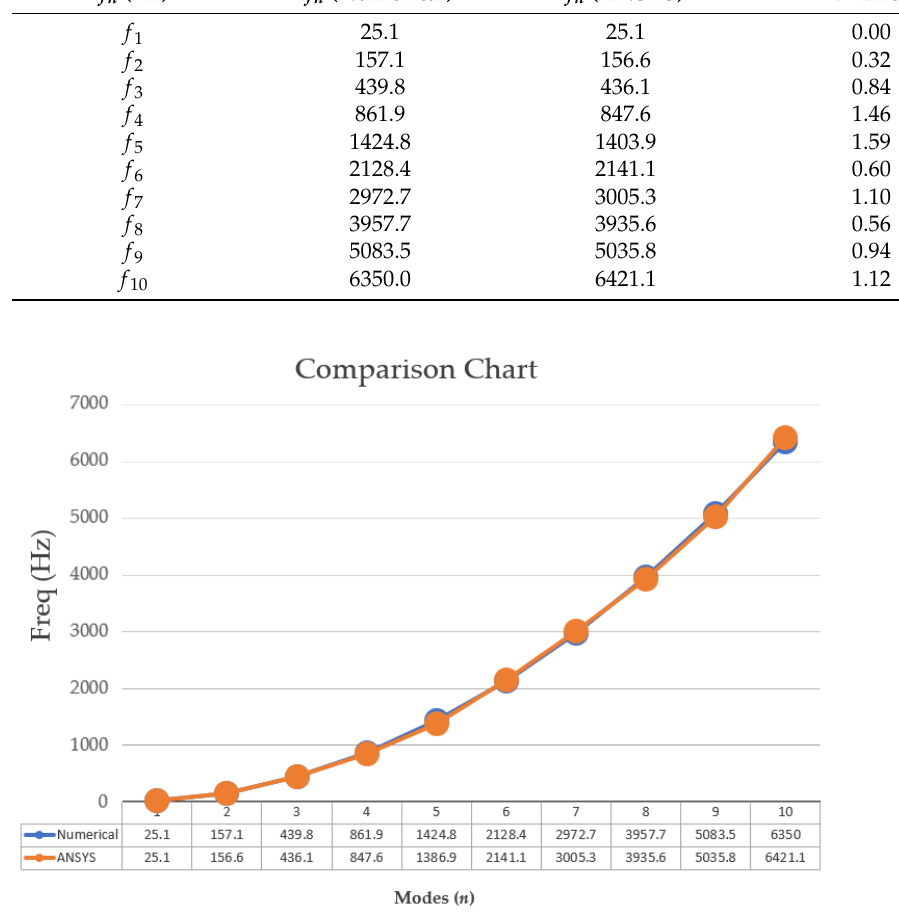
Figure 7. Graphical comparison of f n results for ten